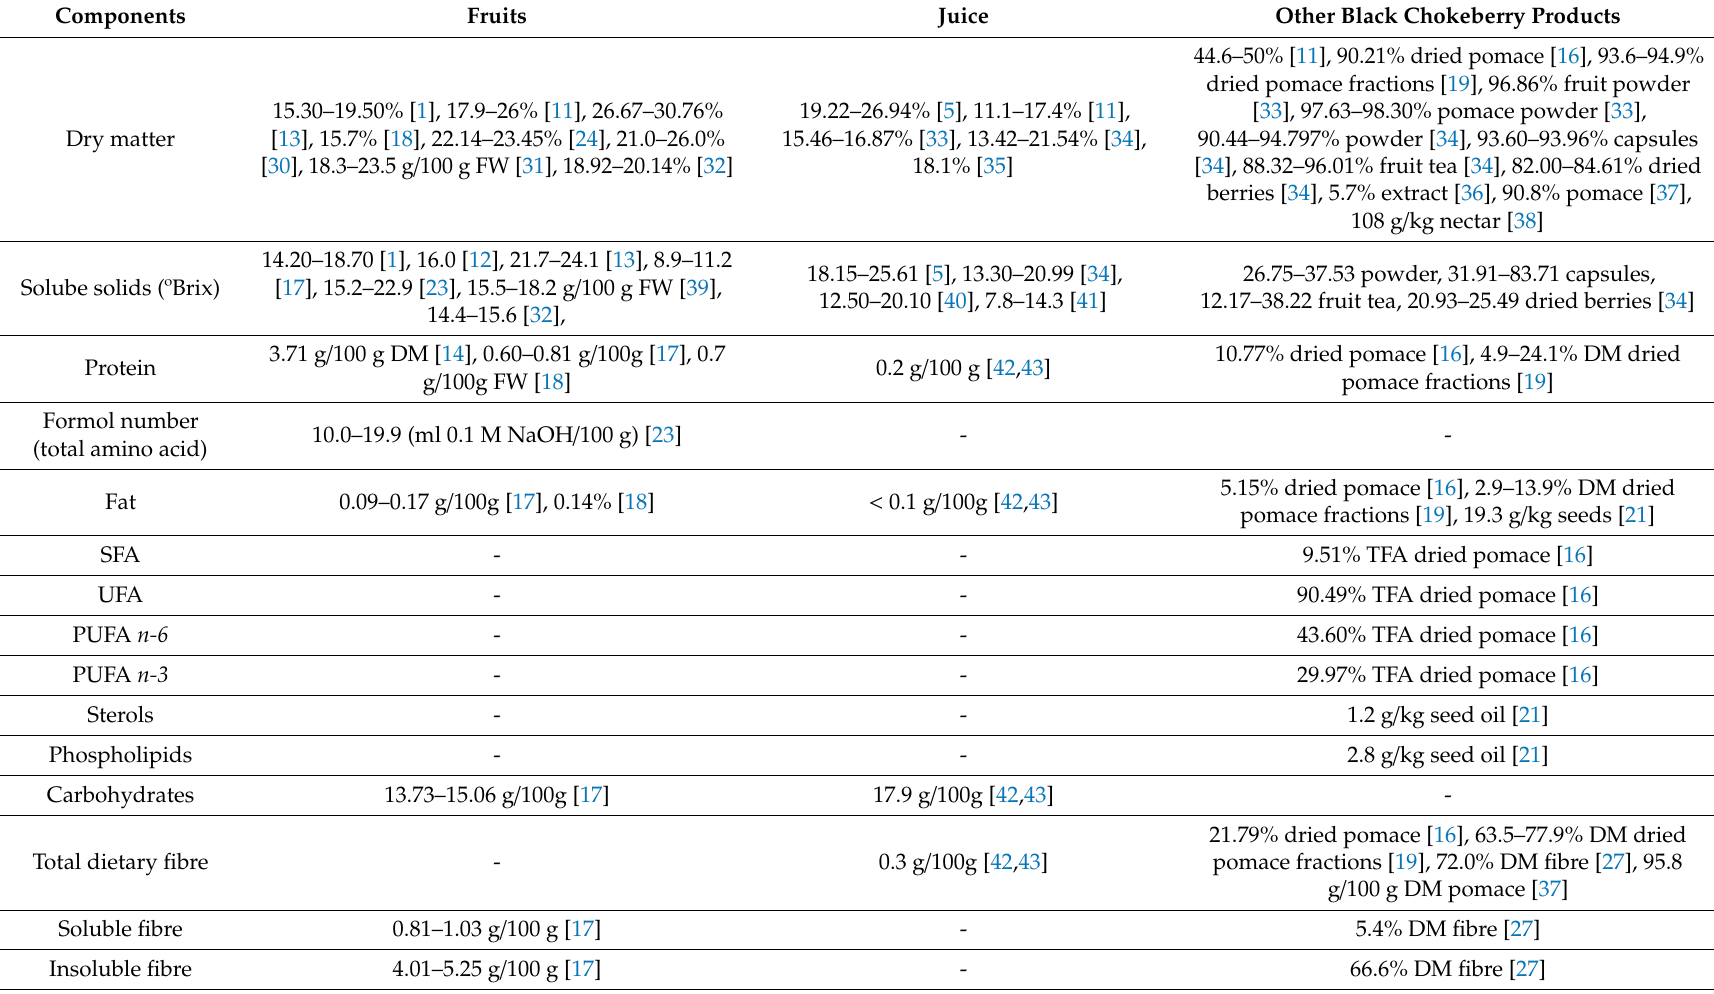
Table 1. The qualitative composition of fruits, juice and other black chokeberry